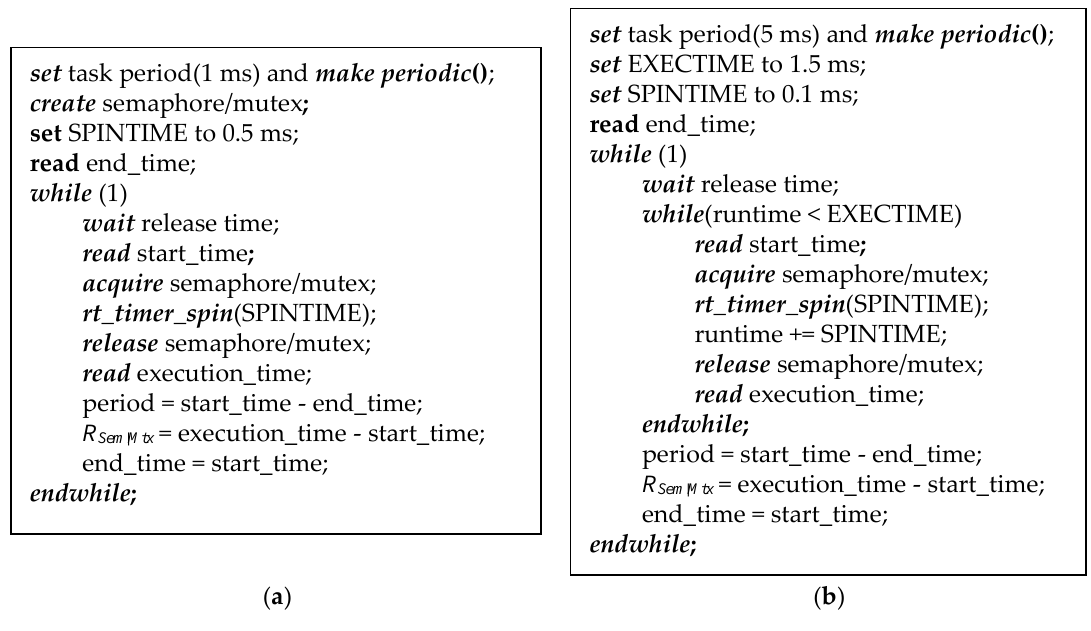
Figure 4. Pseudo code for measuring the response time of real-time tasks with mutex and semaphore: ( a ) high priority task, τ 1 ; ( b ) low priority task, τ 2 . Note that the same pseudo code can be applied in the periodicity and response time test (previous section) but omitting the mutex/semaphore operations.